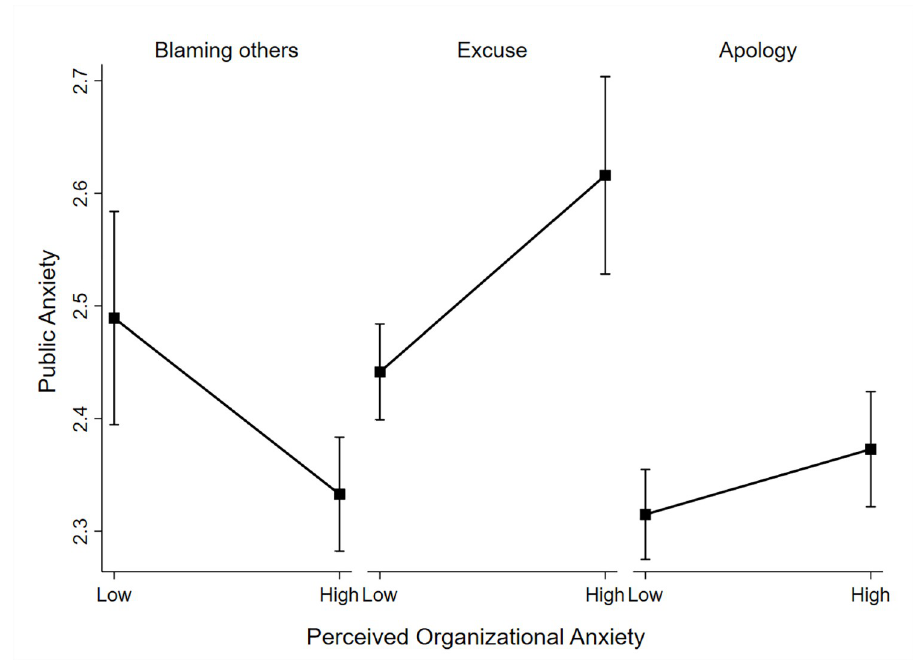
Fig 1. Interaction between perceived organizational anxiety and crisis response strategies on public